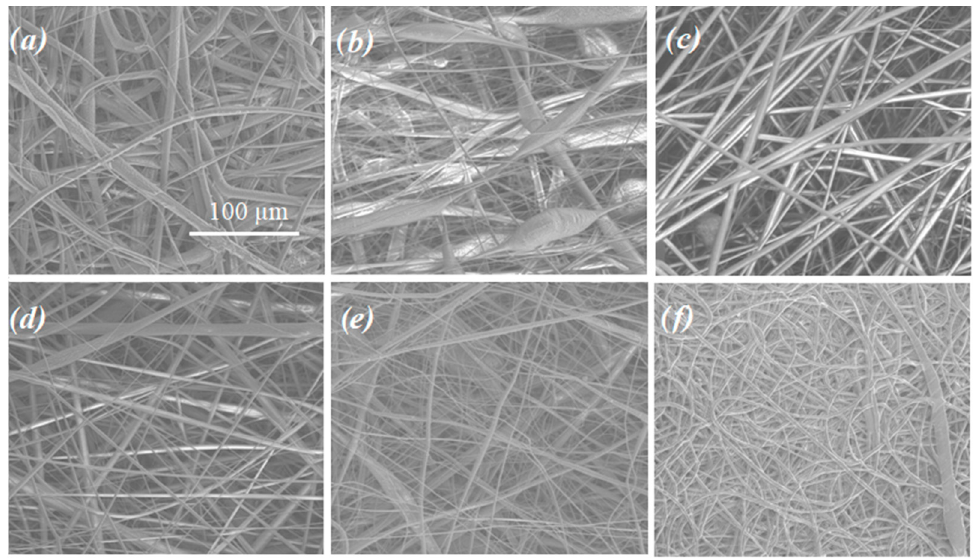
Figure 1. SEM micrographs of drug-loaded nonwoven patches obtained by electrospinning; ( a ) (PGCL/PLGA) + CTX, ( b ) (PGCL/PLGA) + DTX, ( c ) (PLTMC/PLGA) + DTX, ( d ) PLGCL + DTX, ( e ) PLGA + DTX, ( f ) drug- free PGCL/PLGA.